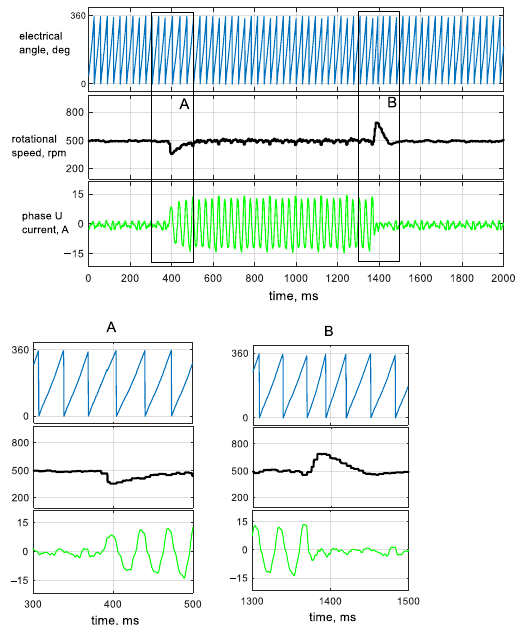
Figure 12. The course of the estimated value of the Θ M angle, the measured rotational speed and the motor phase U current for a closed-speed loop regulator system and a load torque change of 0 – 50 – 0% of nominal torque. of nominal